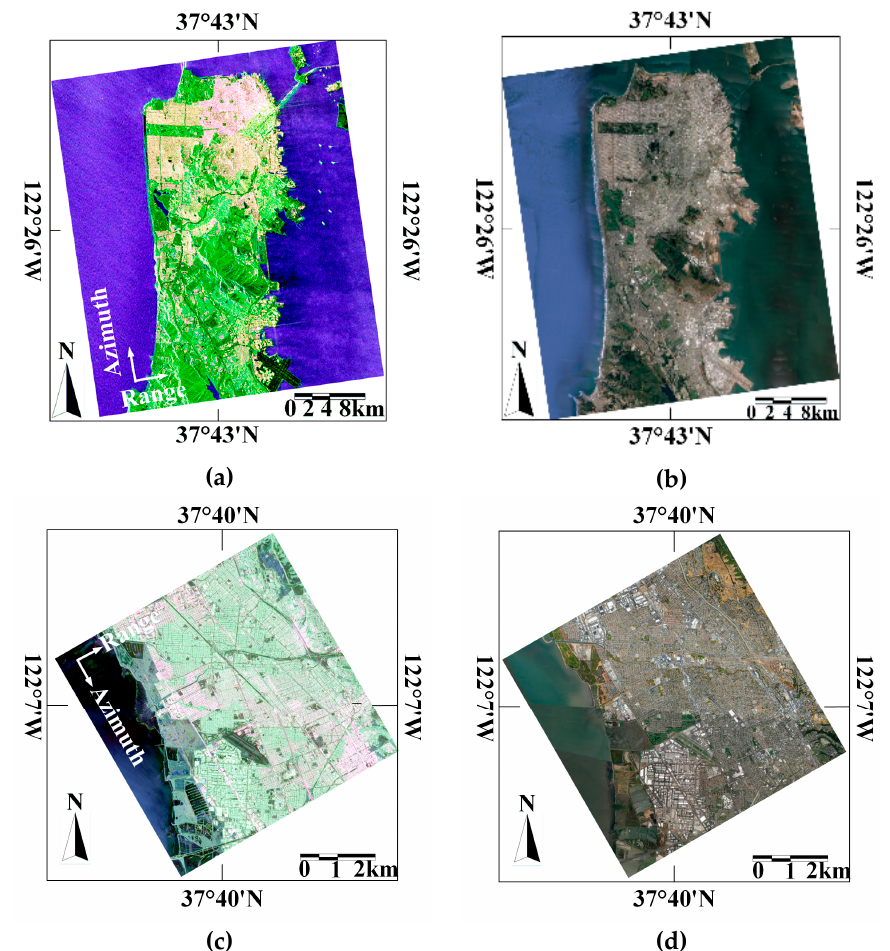
Figure 1. Pauli color-coded images and the corresponding optical images. ( a )–( b ) Gaofen-3 (GF-3) data. ( c )–( d ) uninhabited aerial vehicle SAR (UAVSAR) data.